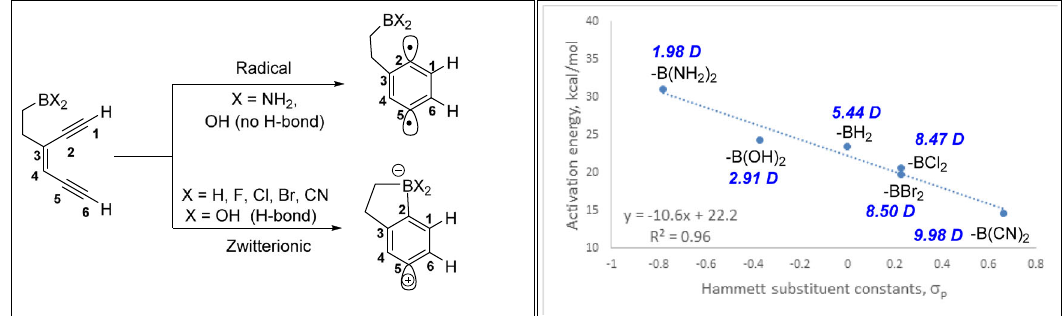
Fig. 9 The scheme on the left show two possible outcomes when enediynes containing electronically diverse boryl groups undergo BC . The plot on the right shows the dependence of activation energy on the electrophilicity of boryl groups. Values in blue font indicate the net dipole moment of the TS.